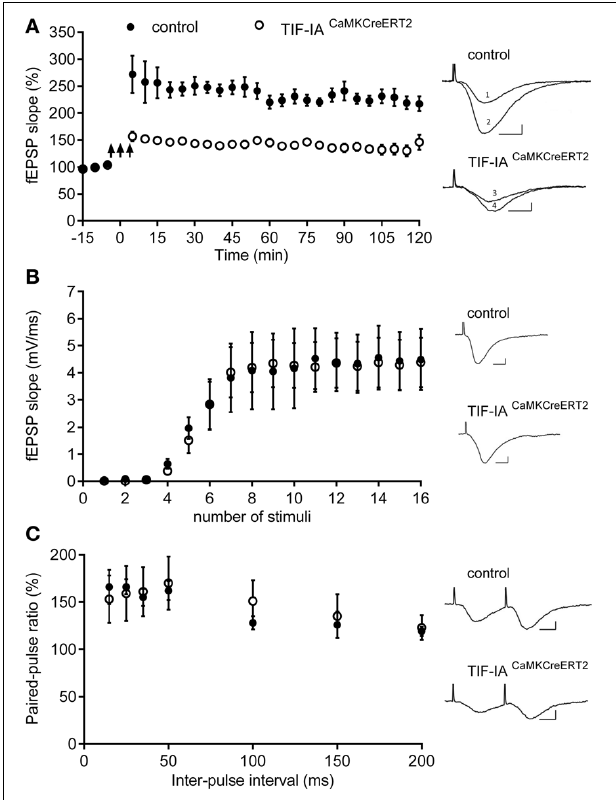
FIGURE 6 | TIF-IA CaMKCreERT2 mutant mice display hippocampal deficits in LTP. (A) Tetanically induced LTP is lower in TIF-IA CaMKCreERT2 mutant mice (open circles) in comparison with control group (filled circles) 1 month after tamoxifen. Arrows mark the stimulation (3 trains of 100Hz, 1s stimulation separated by 3min; n = 5, control; n = 6, mutant). Each point represents the average of 5min recording from each animal group ± SEM. Right panels: superimposed representative fEPSP traces recorded from control and TIF-IA CaMKCreERT2 mutant mice 10min before LTP induction (1 and 3, respectively) and 120min after (2 and 4, respectively). Scale bars: 5ms/2mV. (B) Input-output (IO) curves representing the relationship between stimulus intensity and the slope of the fEPSP, did not differ significantly between control animals (filled circles; n = 5) and TIF-IA CaMKCreERT2 mutant mice (open circles; n = 6). Right panels: representative fEPSP traces with maximal slope, recorded from control (upper panel) and TIF-IA CaMKCreERT2 mutant mice (bottom panel). Scale bars: 5ms/2mV. (C) There were no differences in paired-pulse facilitation (PPF) ratios induced by delivering two stimuli with several different inter-stimulus intervals (15, 25, 35, 100, 150, and 200ms) between control animals (filled circles; n = 5) and TIF-IA CaMKCreERT2 mutant mice (open circles; n = 6). The PPF ratio represents the slope of the second fEPSP divided by the slope of the first fEPSP presented in %. (Right panels) Representative fEPSP traces evoked by two stimuli with the same intensity and inter-stimulus interval 15ms, recorded from control (upper panel) and TIF-IA CaMKCreERT2 mutant mice (bottom panel). Scale bars: 5ms/2mV.